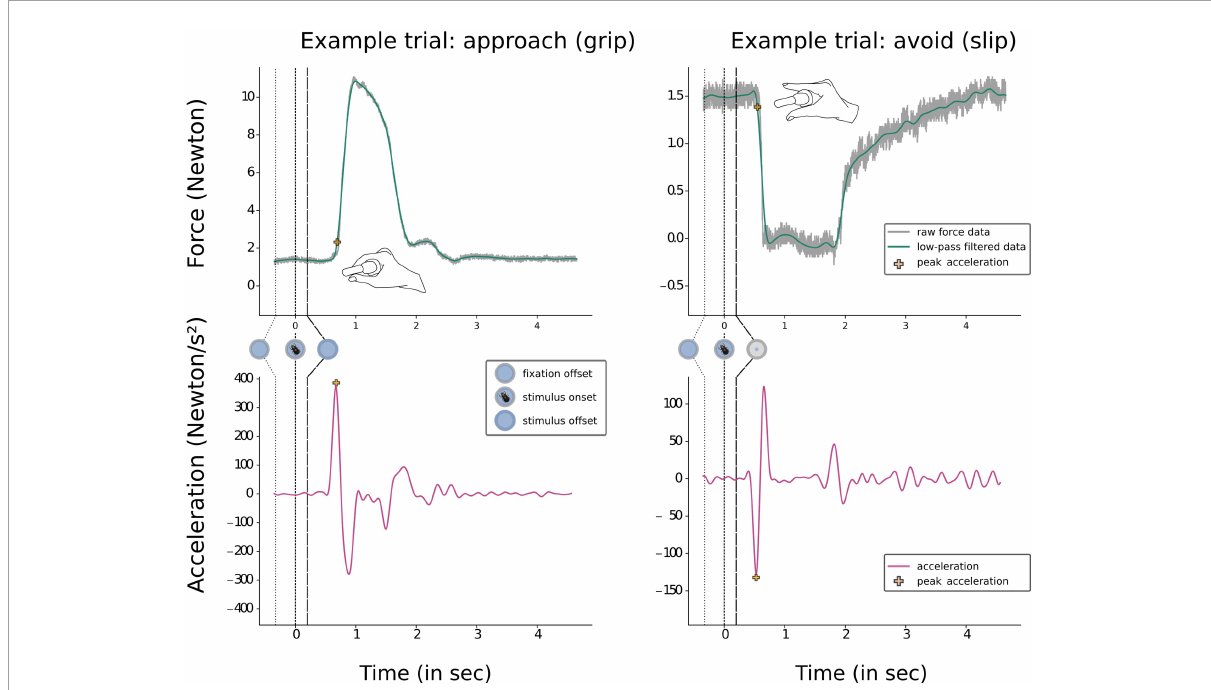
FIGURE3 Examples of time force curves during a grip and a slip trial. The two upper boxes depict raw force data and the subsequent low pass filtered data, with the point of peak acceleration marked by a yellow cross. The time point of peak acceleration was used to extract our first dependent variable of interest; response initiation time (RIT). Prior to responding participants were pressing the device at a baseline level (2% of MVC). The lower two boxes illustrate the second derivate of the time force curve, force acceleration. Again, the peak acceleration is marked by a yellow cross. Here, the magnitude of peak acceleration was used to extract or second dependent variable of interest: peak response acceleration